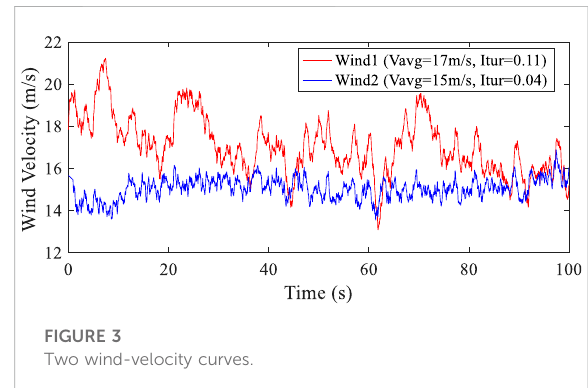
FIGURE 3 Two wind-velocity